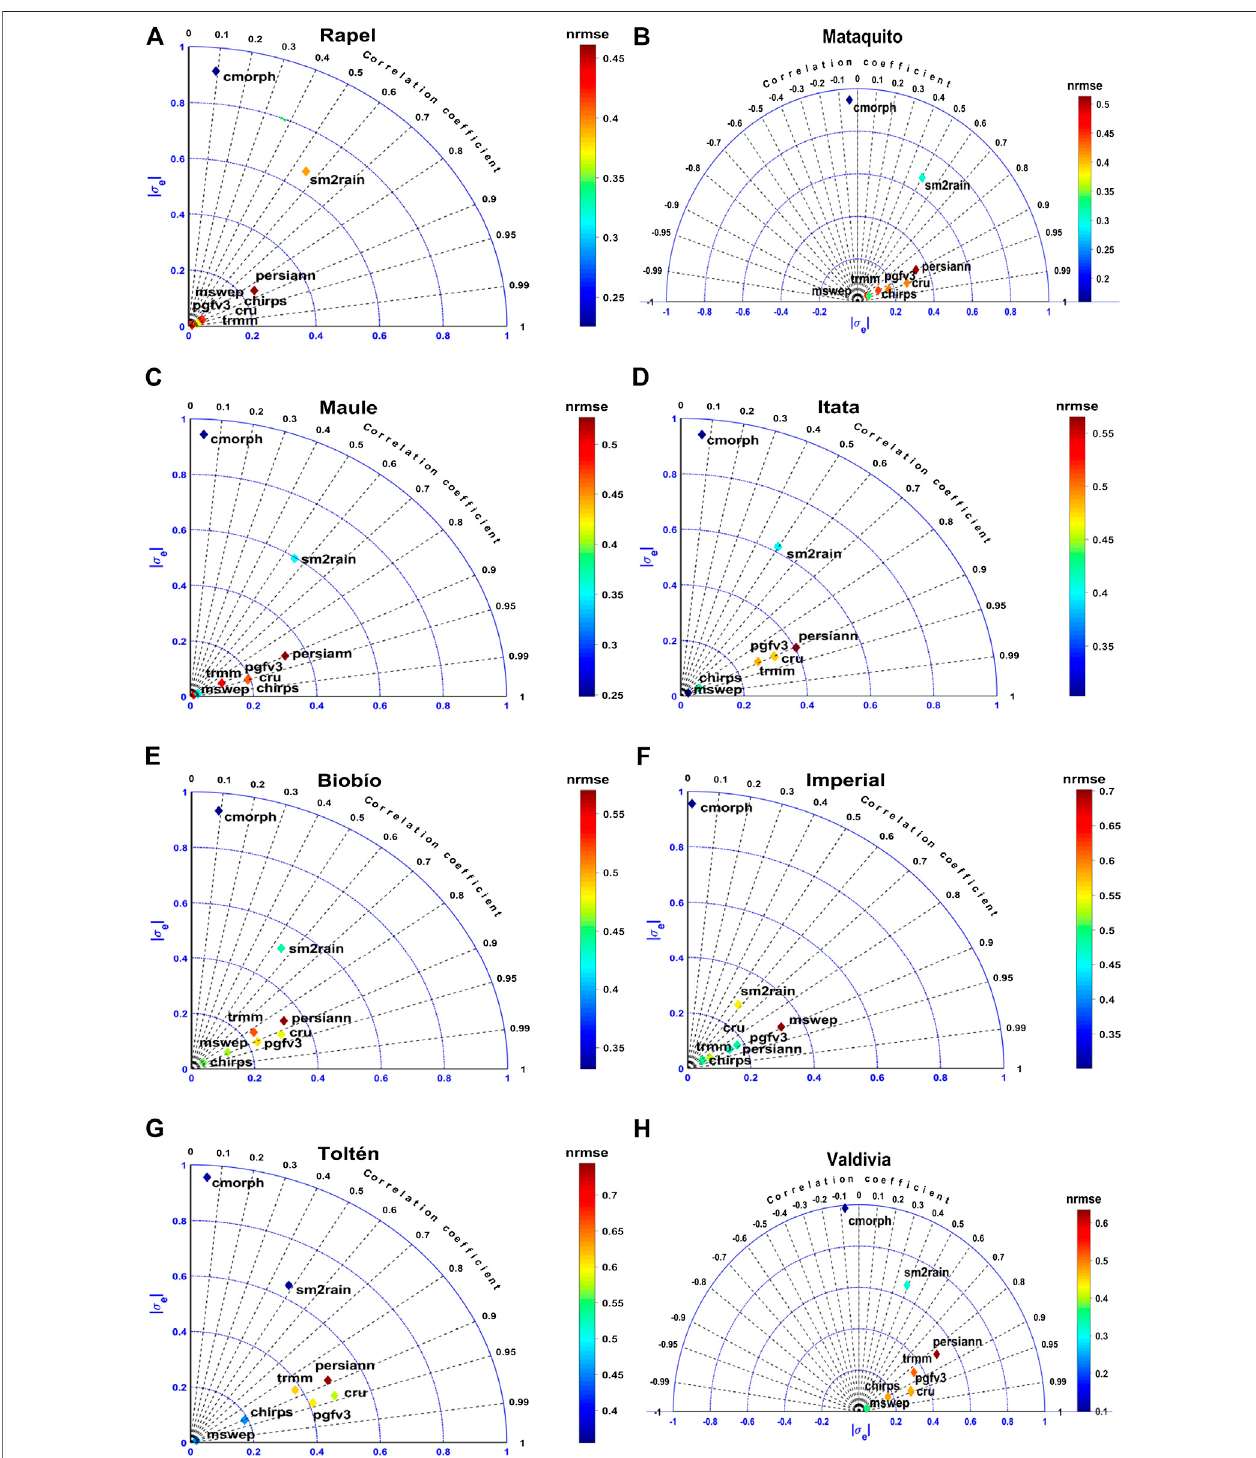
FIGURE 8 | Taylor ’ s diagrams corresponding to the gridded set performance ( Table 2 ), once fi tted ( Eq. 2 ) on the river basins of (A) Rapel, (B) Maule, (C) Itata, (D) Biobío, (E) Imperial, (F) Toltén, (G) Mataquito, and (H) Valdivia.